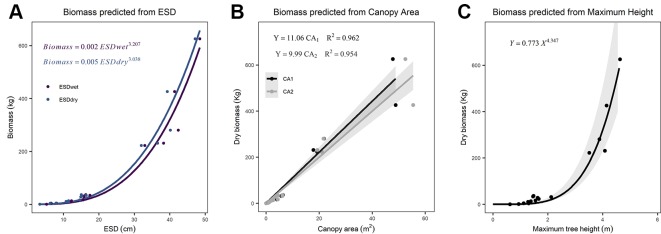
Relationships between explanatory variables and aboveground biomass (AGB) for (A) equivalent stem diameter (ESD) using both wet and dry measurements (n = 15), (B) canopy area (n = 18), and (C) maximum tree height (n = 18). The shaded areas indicate the 95% prediction intervals on panel (C) and the 95% confidence interval on (B). Details of all models and parameters are in
Table 2
.